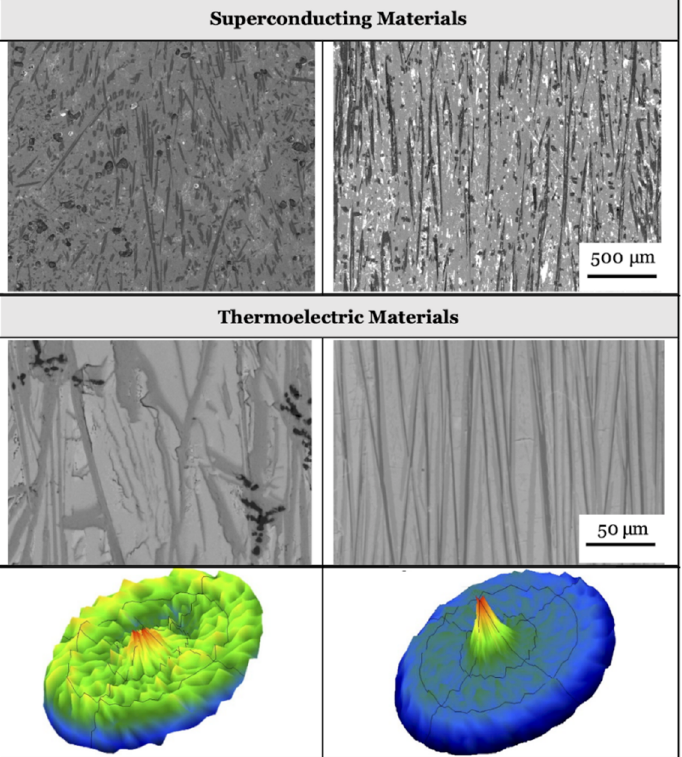
Figure 5. Micrographs performed on longitudinal polished sections of superconducting (Bi 2 Sr 2 CaCu 2 O x ) and thermoelectric (Bi 2 Ca 2 Co 1.7 O x ) materials grown by LFZ ( left ) and EALFZ with 300 mA ( right ). Pole figures of cross sections of the thermoelectric samples highlight the beneficial effect of the electrical current application on the grain alignment during the crystallization process (adapted with permission [147], Copyright 2014, Elsevier).